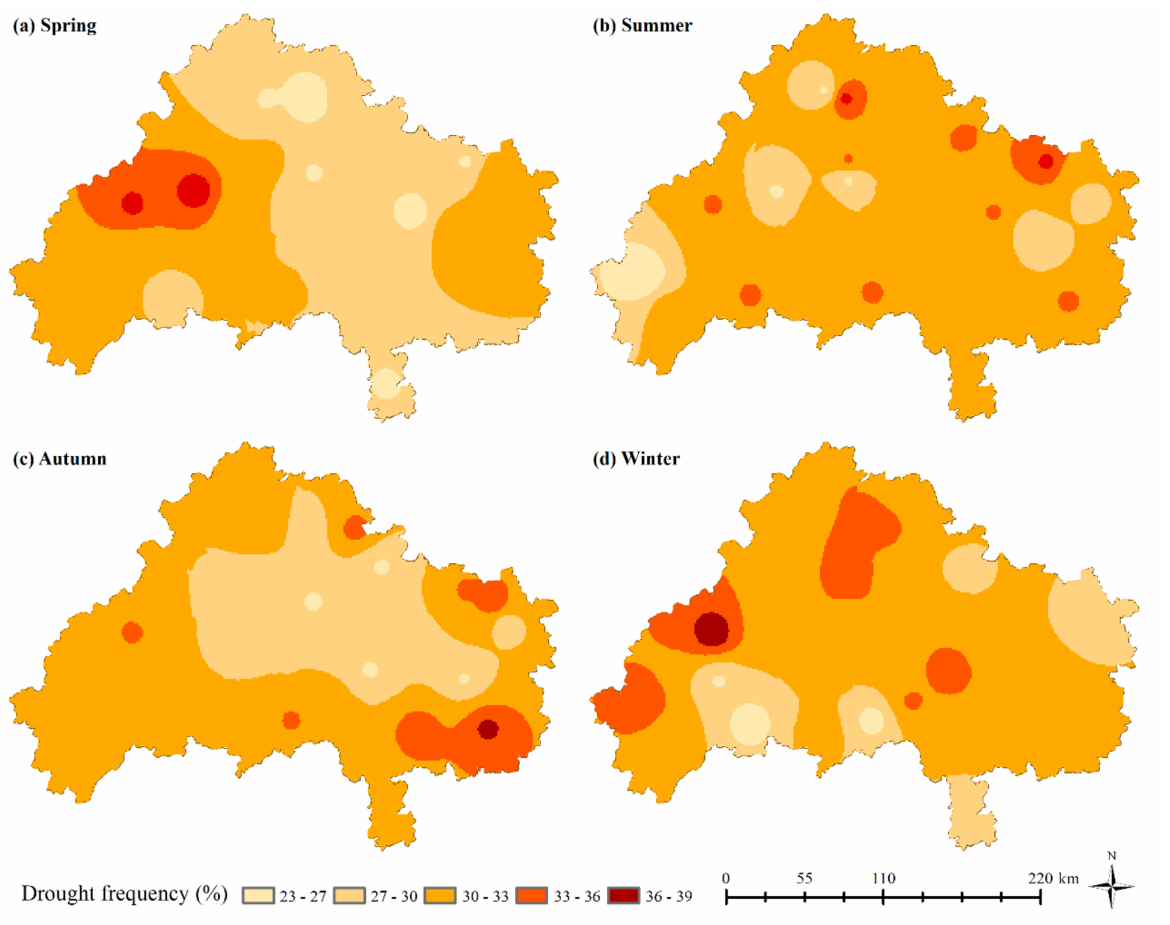
Figure 11. Spatial patterns of seasonal drought frequency in HSDC. ( a ) Spring drought frequency; ( b ) summer drought frequency; ( c ) autumn drought frequency; and ( d ) winter drought